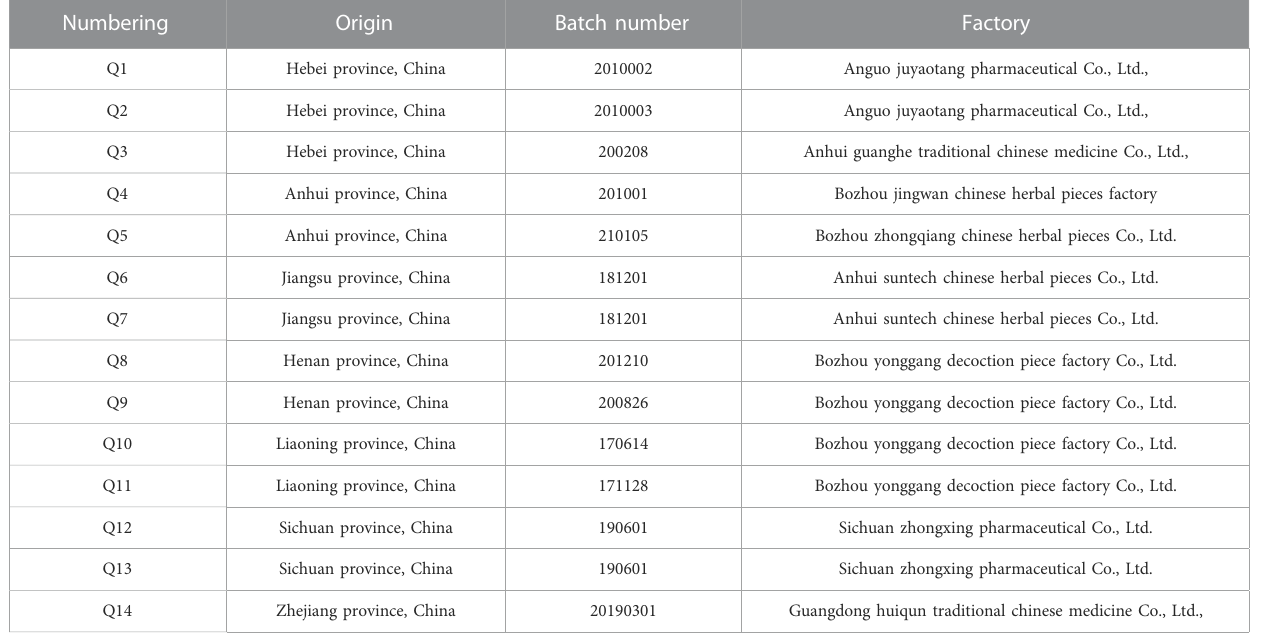
TABLE 1 14 batches of PS samples from different